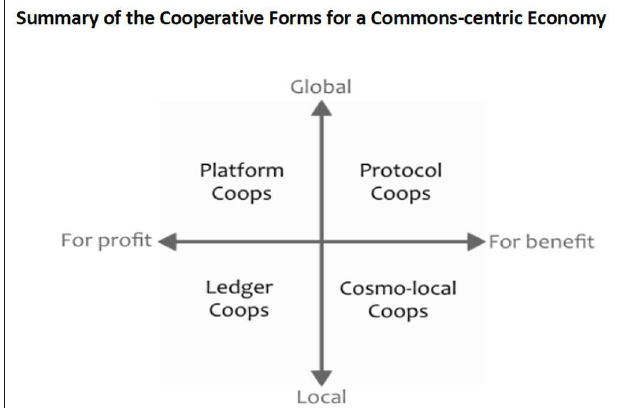
FIGURE 4 | Summary of the cooperative forms in commons-centric economies (used with permission. Graphic by Michel Bauwens, to be published in “P2P Accounting for Planetary Survival,” P2P Foundation, upcoming